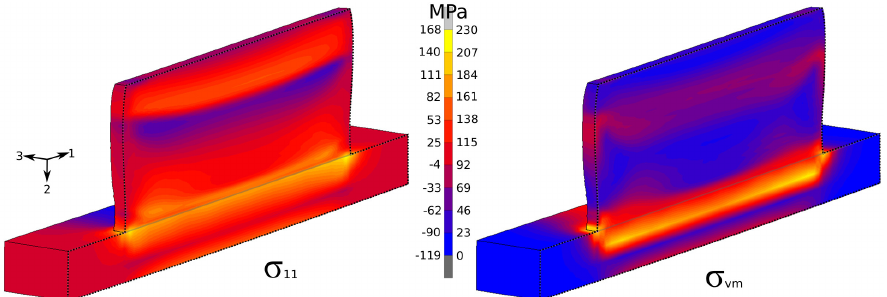
Figure 12. Residual stress for 0 s dwell time (model clipped longitudinally in midplane).